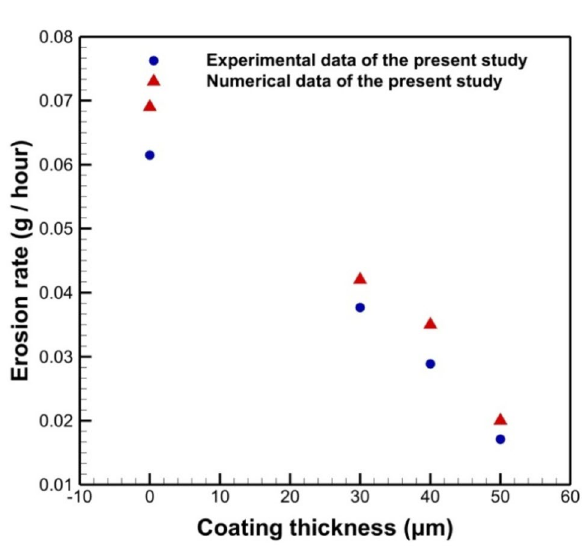
Figure 19. Comparison between the experiment and numerical data for Erosion rates for different coat